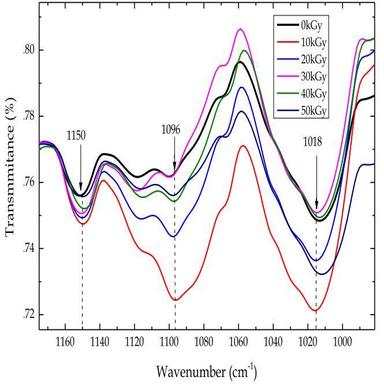
FTIR spectra of PVA/PANI/functionalized CNT nanocomposites film with 6pph of functionalized CNT content at different gamma irradiation doses near the bands at 1150, 1096, and 1015 cm-1.